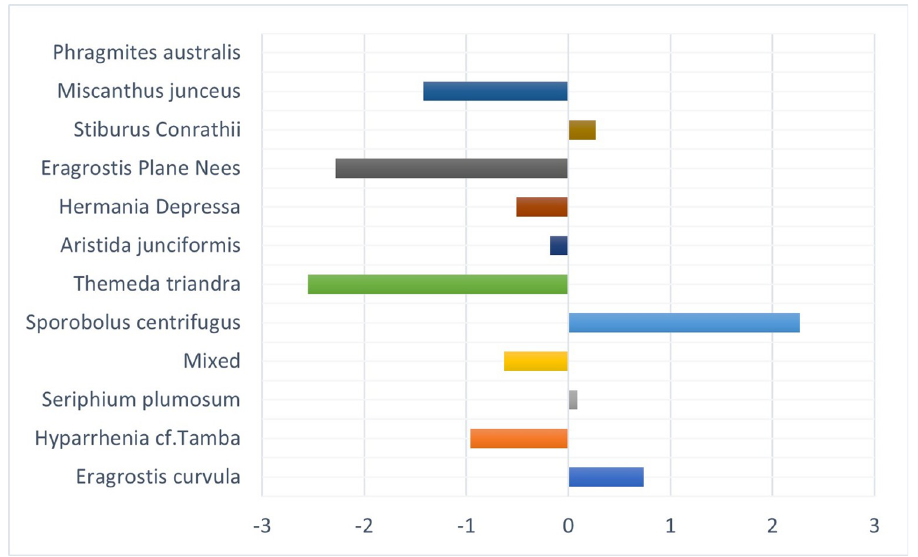
Fig 11. Species contributions to change in Phragmites australis